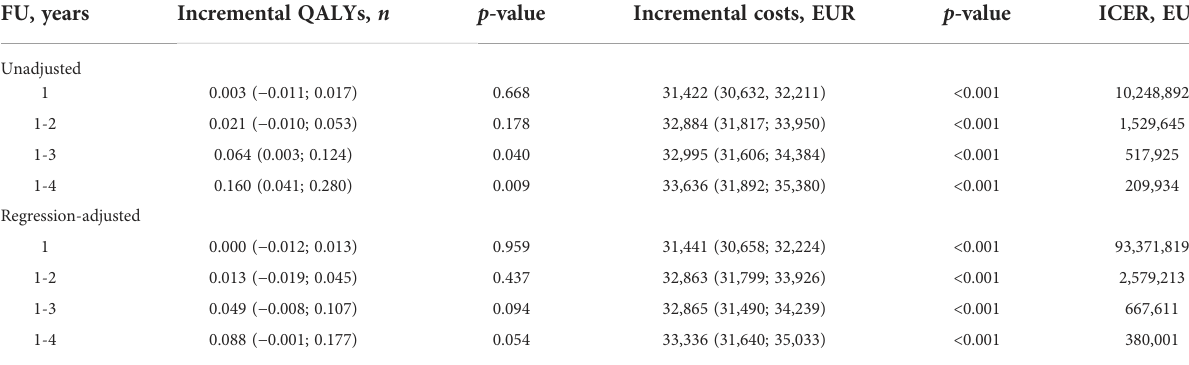
TABLE 3 Cumulative incremental QALYs, costs, and cost-effectiveness ratios by year of FU without and with regression